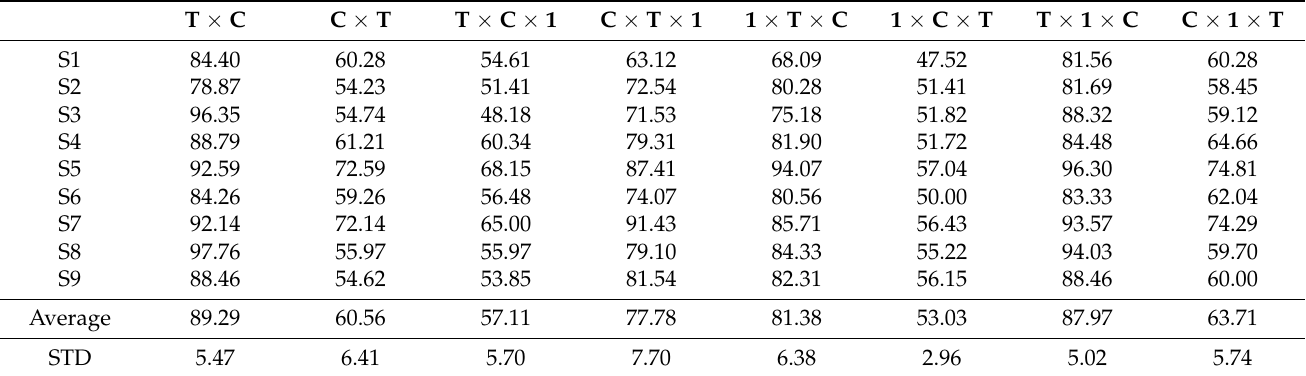
Table 1. Subject-Based and Average Accuracy Values of BCI-IV-2A.